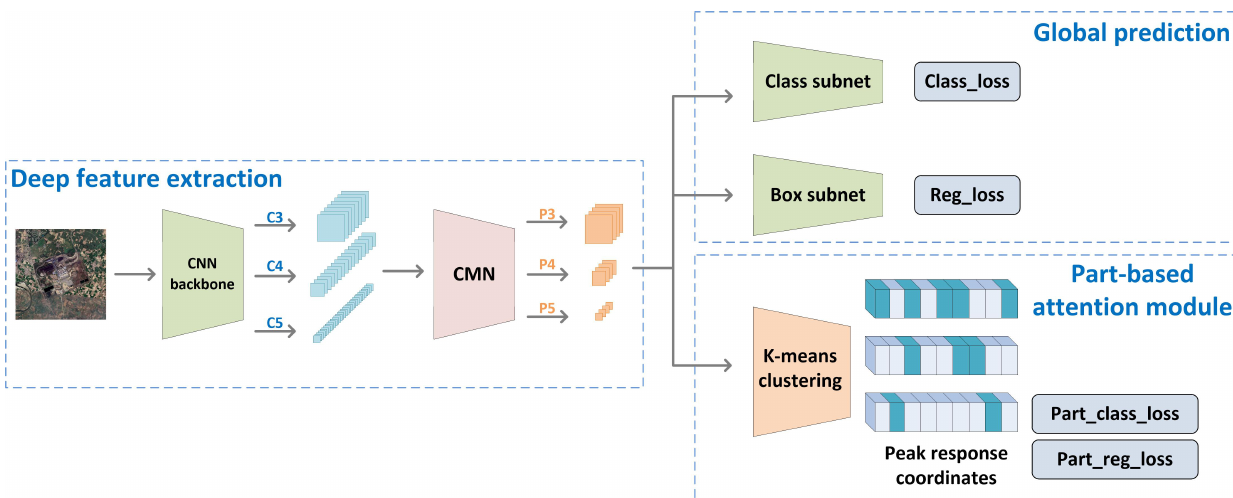
Figure 4. Overall framework of our PCAN, which consists of deep feature extraction sub-network, global prediction sub- network and part-based attention module. In deep feature extraction sub-network, our CMN after the classic Convolutional Neural Network (CNN) produces multi-scale feature maps, which can not only contain contextual information but also model irregular components. Global prediction sub-network includes two subnets, one for predicting the labels for anchors and one for regressing from anchors to ground-truth bounding boxes. Part-based attention module adopts K-means method to cluster feature channels into certain groups, where each group aggregate spatially-correlated patterns, corresponding to one component of Thermal Power Plants